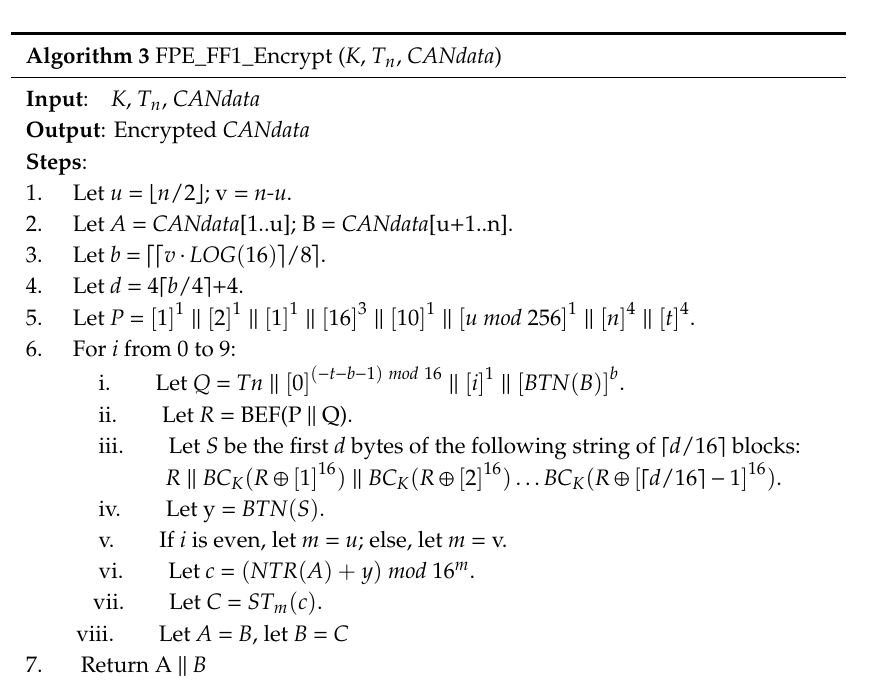
Algorithm 3 FPE_FF1_Encrypt ( K , T n , CANdata